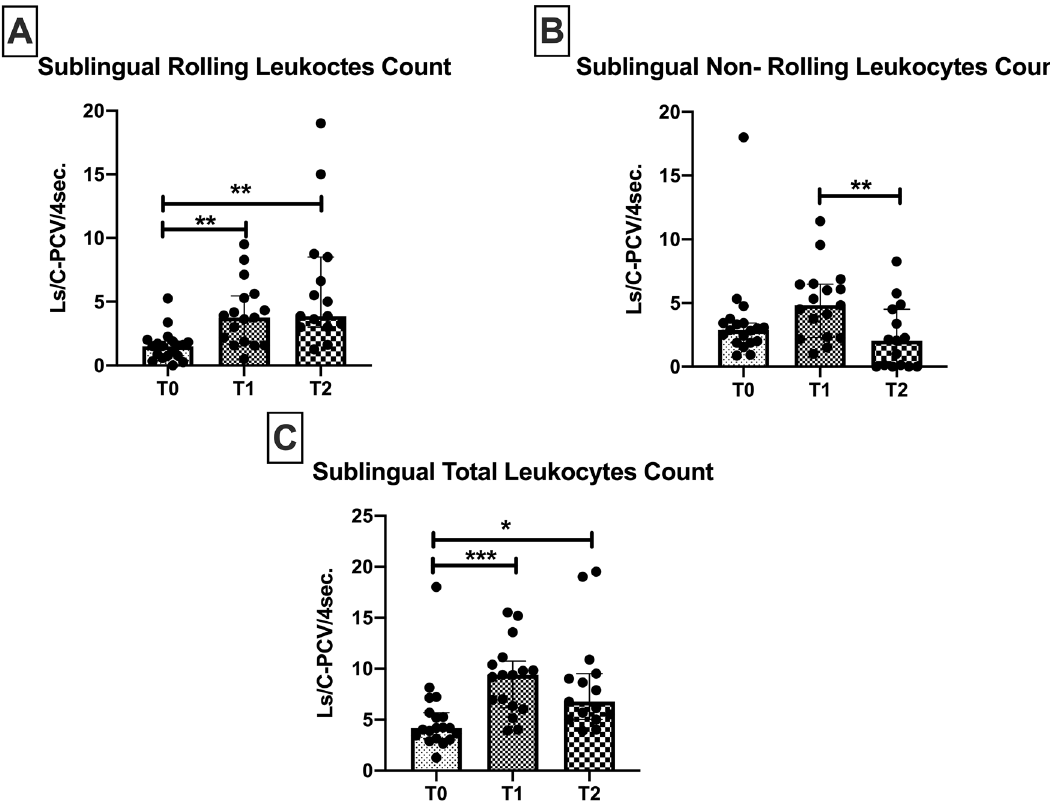
Figure 5. Leukocyte quantification in the sublingual area assessed at the beginning of surgery (T0), end of surgery (T1) and 24 h after surgery (T2). The microcirculatory rolling leukocytes count increased during the time course. Values are represented as median [interquatile] * p < 0.05, ** p < 0.01, *** p < 0.001.